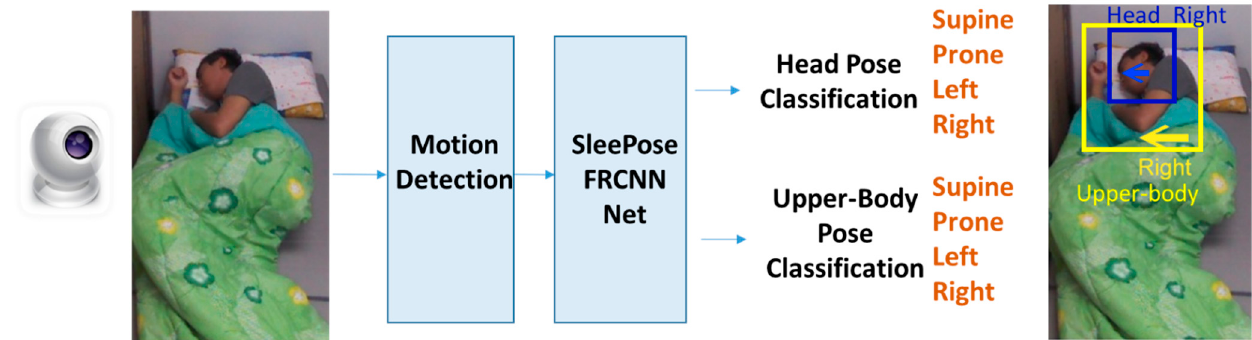
Figure 1. Architecture of the proposed framework.